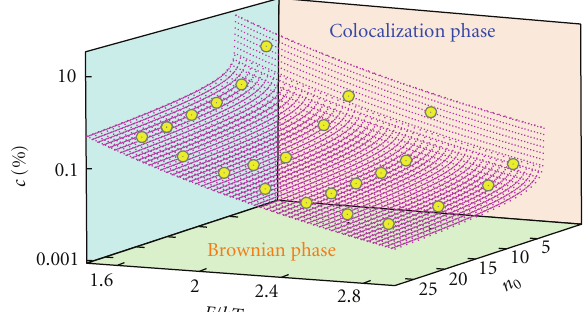
Figure 4: The DNA colocalization happens when specific threshold values in (c,E,n 0 ) are passed. A 3D phase diagram in the space of the molecular factors (MFs) concentration c , the binding sites (BSs) number n 0 , and the MF-BS interaction energy E is shown. When the purple surface is crossed, a transition from a “Brownian Phase” (DNA loci di ff use as random walk polymers) to a “Colocalization Phase” (colocalized DNA loci) occurs. The yellow circles mark the measured transition points (at which the 50% of DNA loci couples are paired); the purple surface was obtained by a power law fit ( cE γ n δ 0 = cost . , γ = 4, δ = 1 .